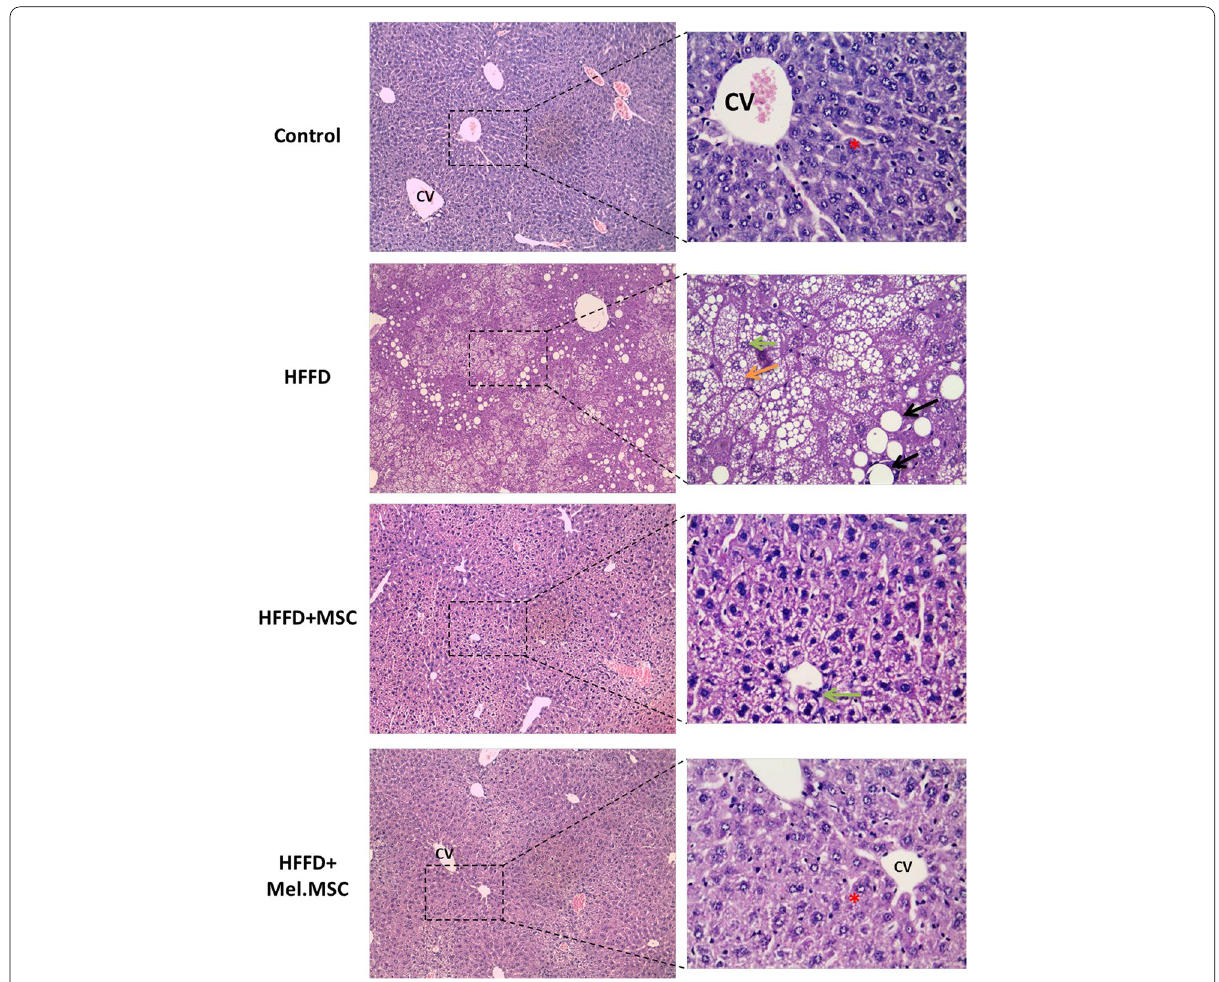
Fig. 6 Photomicrographs of liver: Control group showing normal of hepatic cords (orange star) radiating from the central vein (CV). HFFD group showing macrovesicular steatosis (black arrow), ballooning degeneration with rarefied cytoplasm (orange arrow) and infiltration of inflammatory cells (green arrow). HFFD MSC and HFFD Mel.MSC groups showing normal hepatic cords, moderate infiltration of inflammatory cells without + + any fatty